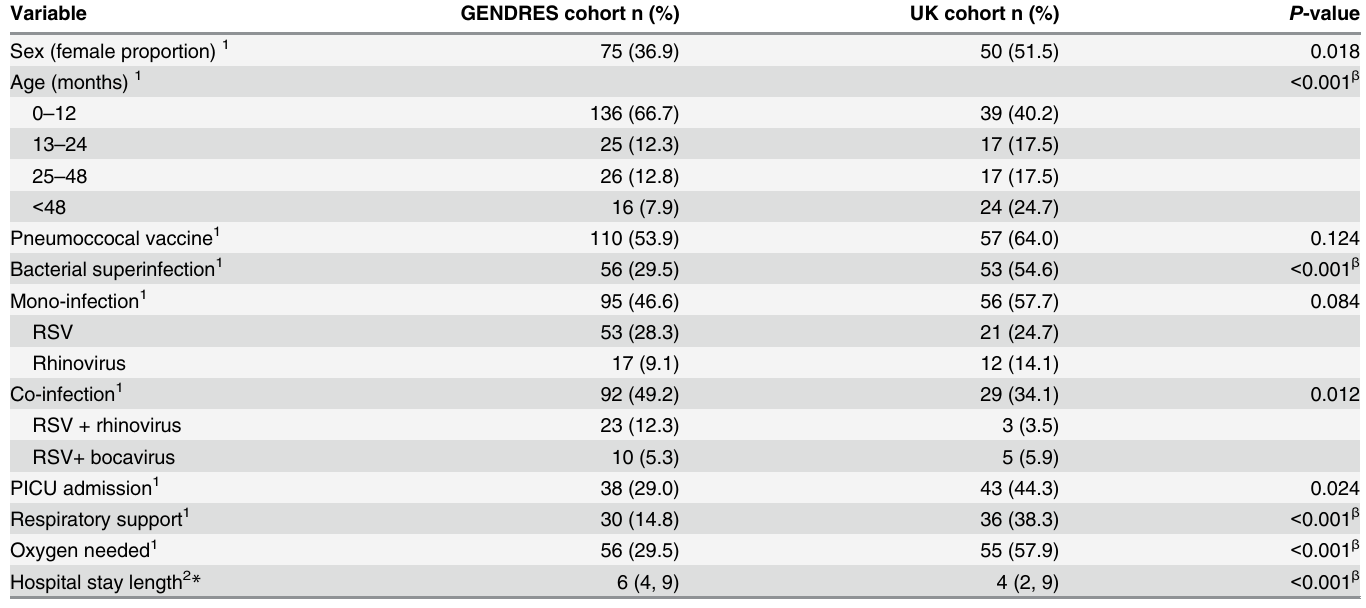
Table 1. Description of the characteristics of the two cohorts analyzed: the GENDRES cohort and the UK cohort. P -value results from the compari- son between both cohorts. A P -value < 0.05 was considered